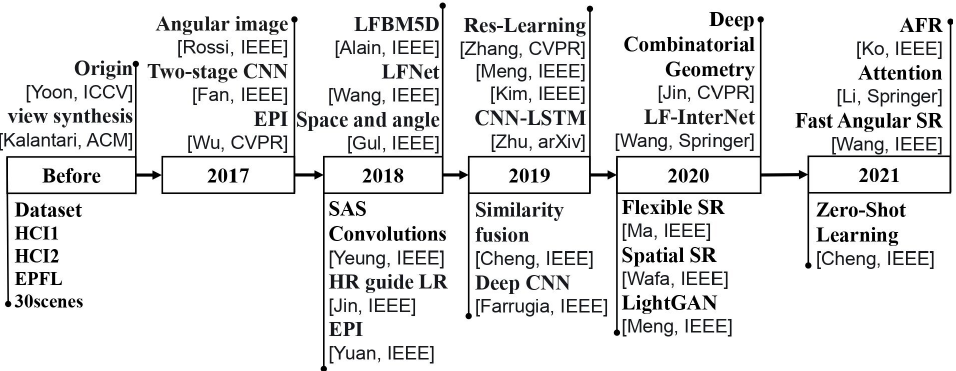
Figure 6. Development timeline of light field super-resolution method based on deep